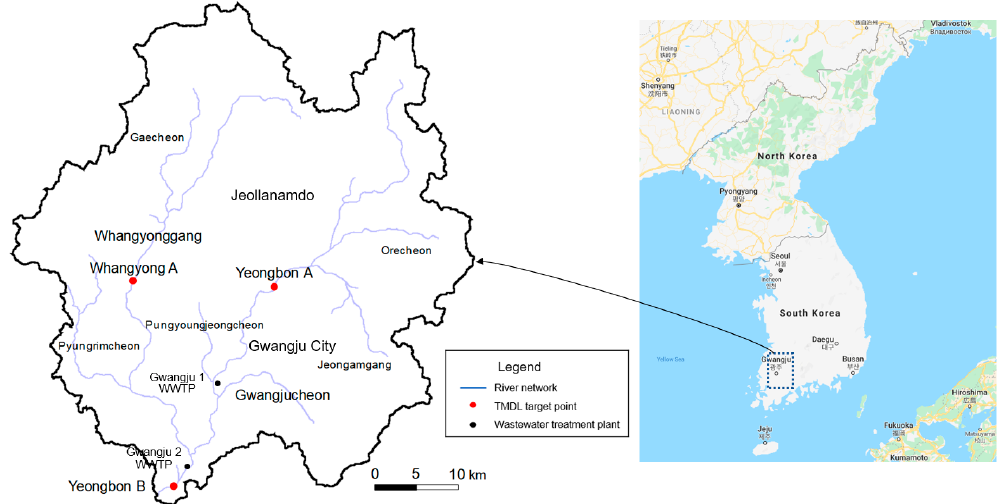
Figure 1. The Yeongsan River basin study area.